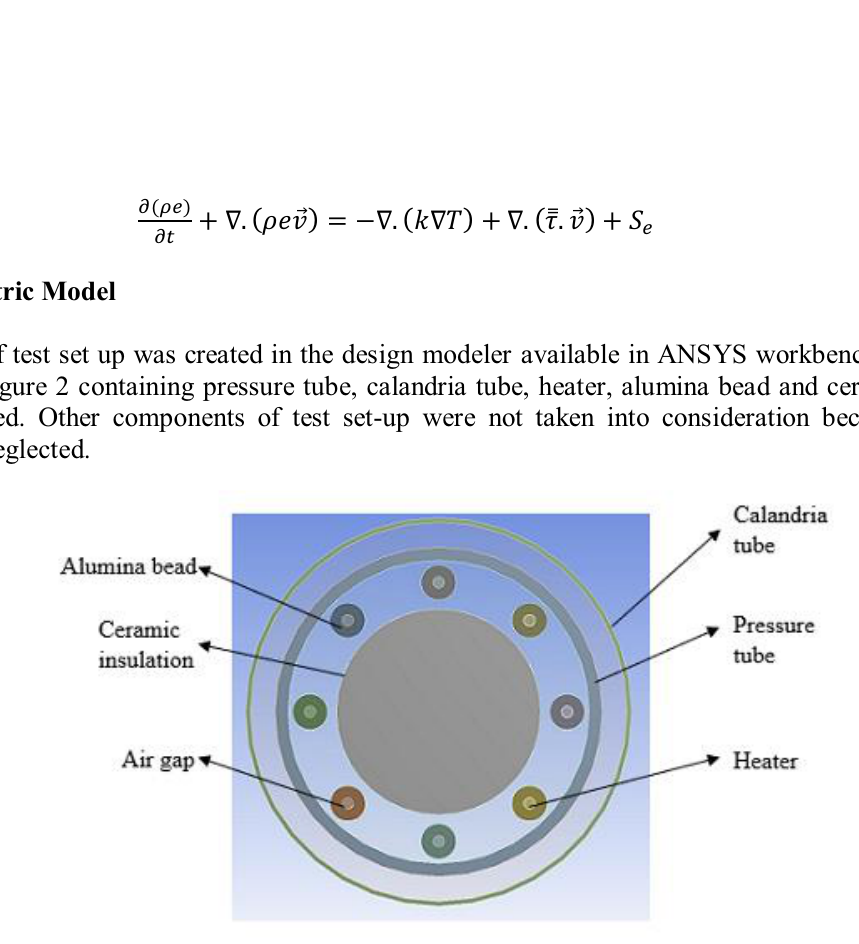
Figure 2. 2D model of test